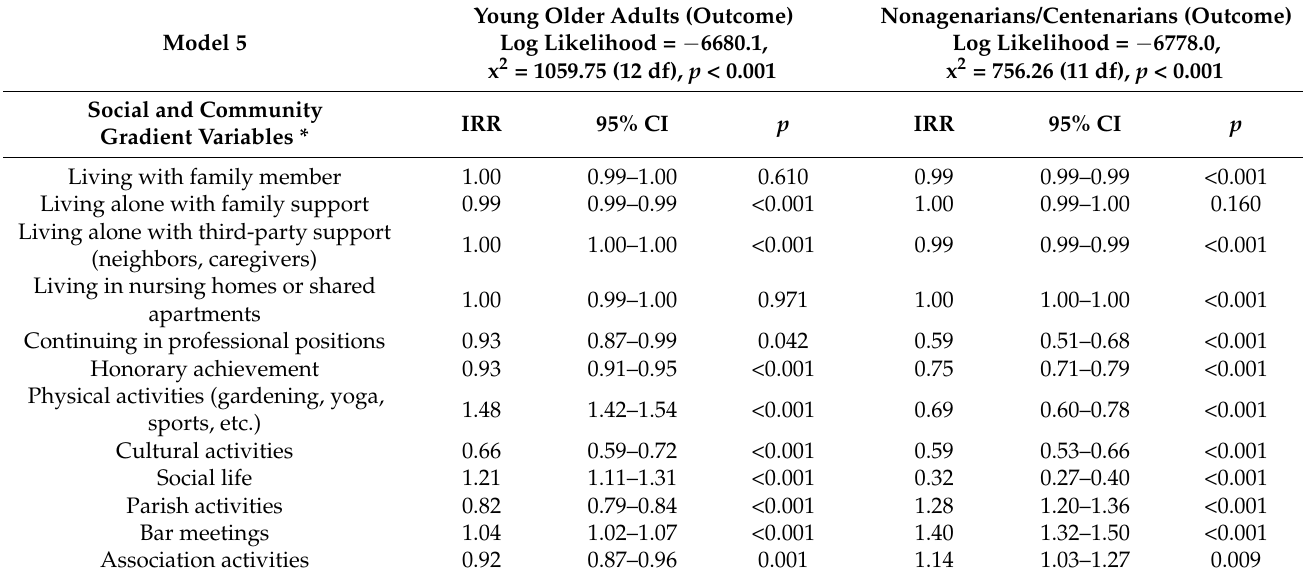
Table 3. Social and community predictors of young older adults and nonagenarians/centenarians.